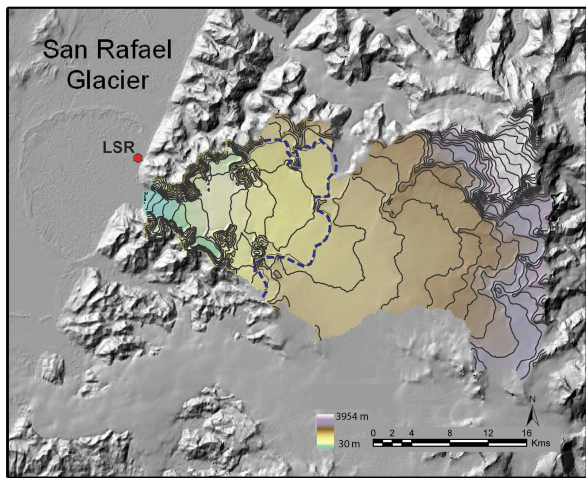
Fig. 2. Digital elevation model of Glaciar San Rafael obtained from SRTM-2000 data. Dashed blue line represents the mean ELA. 100- m contours are indicated in thin black lines. Measurements of daily temperature and precipitation were collected at CONAF field station LSR, along the Andean